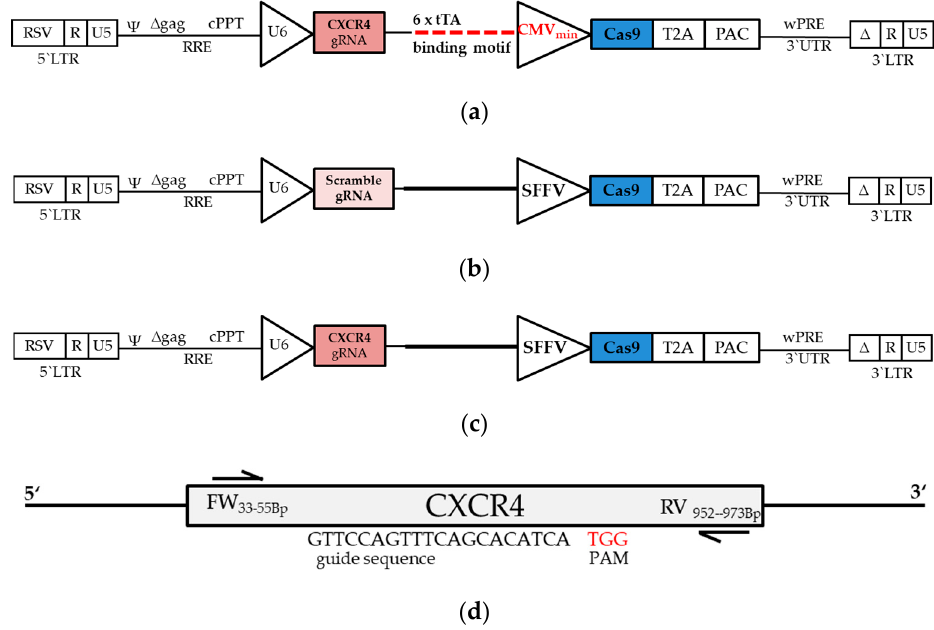
Figure 5. Schematic overview of lentiviral constructs: A scramble ( a ) or CXCR4-targeting ( b ) guide RNA was expressed under the control of the U6 promoter and served as a negative or positive control, respectively. Constitutive ( a , b ) or inducible ( c ) expression of hspCas9 was linked via a 2A self-cleaving peptides from thosea asigna virus (T2A) site to puromycin- n -acetyltransferase for later selection. ( d ) The amplicon length of the CXCR4 gene was su ffi cient for all analyses after gene